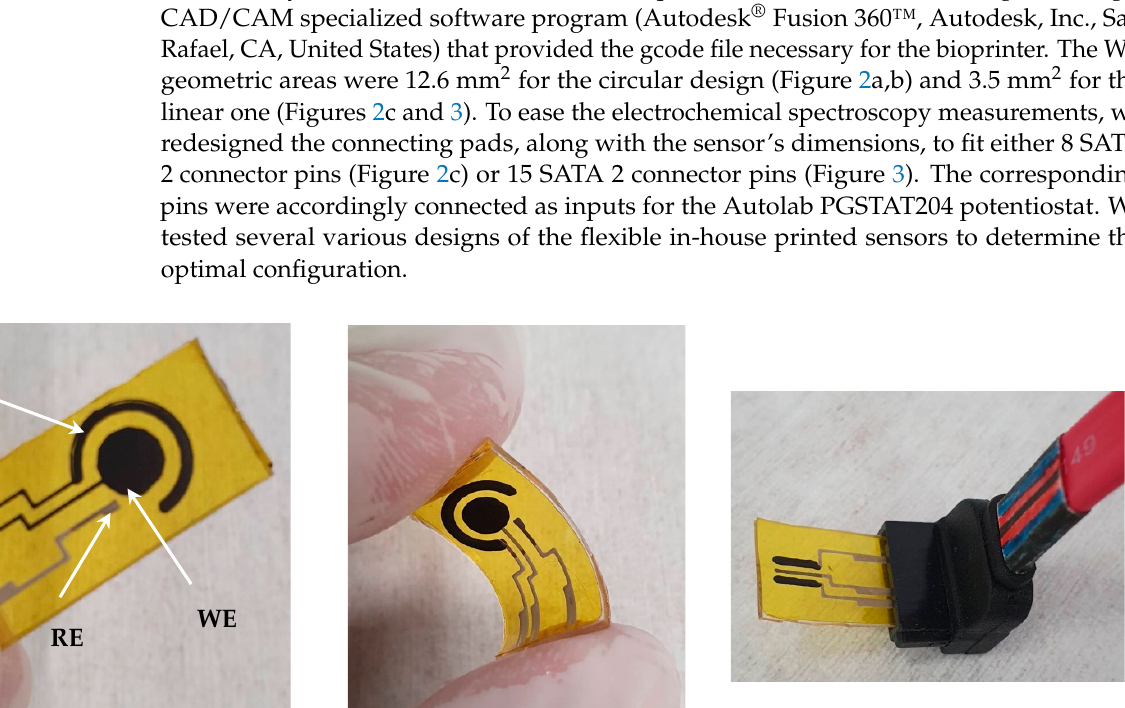
Figure 3. Electrochemical sensor array with 3 carbon-based sensors on a rigid substrate (30 × 20 mm), with 5 electrodes: WEx3 and CEx1 were completely carbon-based, and REx1 was made from Ag/AgCl. The fi rst variants were fully printed with the silver paste: The electrodes, electric routes, pads, and the interest areas of WE and CE were subsequently covered with car- bon paste after the fi rst thermal treatment to dry Ag deposition (Figure 2b,c). This was a laborious process, with high precision requirements to cover the existing routes and maintain the sensor integrity. It proved not to be the best approach, con fi rmed using the early CV measurements, which indicated additional peaks due to the silver–carbon in- terface (Figure A1). Therefore, to improve the printing stage and the quality of the sen- sors, we turned to a di ff erent approach. We printed with silver paste only the reference